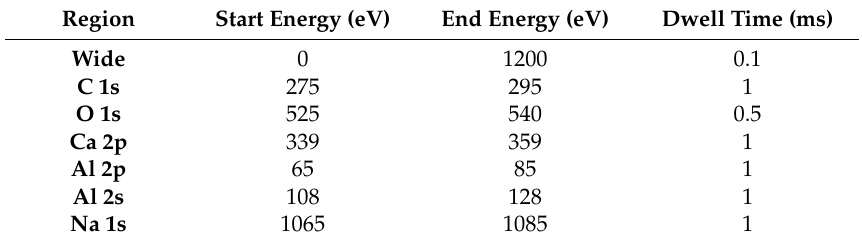
Table 1. Details of the spectral lines recorded by XPS (X-ray Photoelectron Spectroscopy).